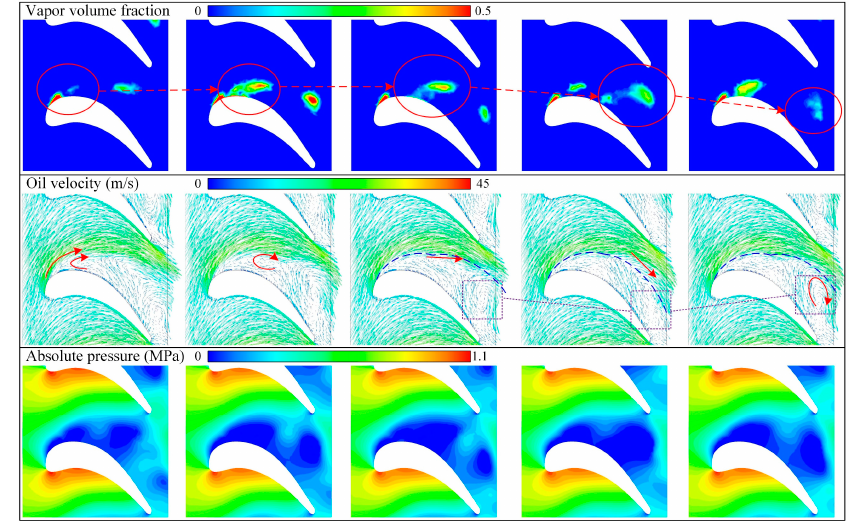
Figure 22. Transient cavitation fl ow fi